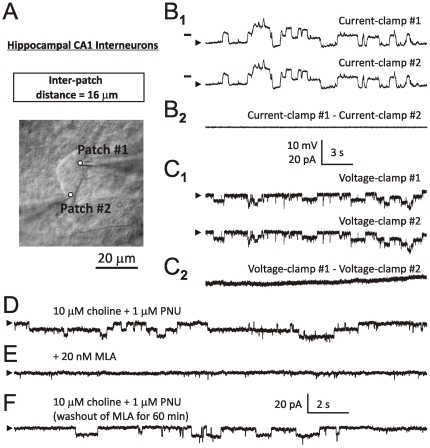
Somatic integration of individual α7 channel activity in hippocampal CA1 interneurons.A hippocampal CA1 interneuron with two attached patch-clamp electrodes and an inter-patch distance of 16 µm (A). Examples of patch-clamp recordings obtained from the neuron shown in (A) when both patch electrodes are in current-clamp (B1) or voltage-clamp at −80 mV (C1). Results of subtraction of trace #2 from trace #1 in current-clamp (B2) and voltage-clamp (C2) indicating identical patterns of α7 single ion channel activity recorded by the two electrodes (see text). Horizontal bars in (B) indicate the membrane voltage of −75 mV. A continuous hyperpolarizing current (50–120 pA) was injected into cells to cease spontaneous firing. The baselines are indicated by arrowheads. Step-like responses (D) were completely (E) and reversibly (F) blocked by 20 nM MLA added to ACSF.